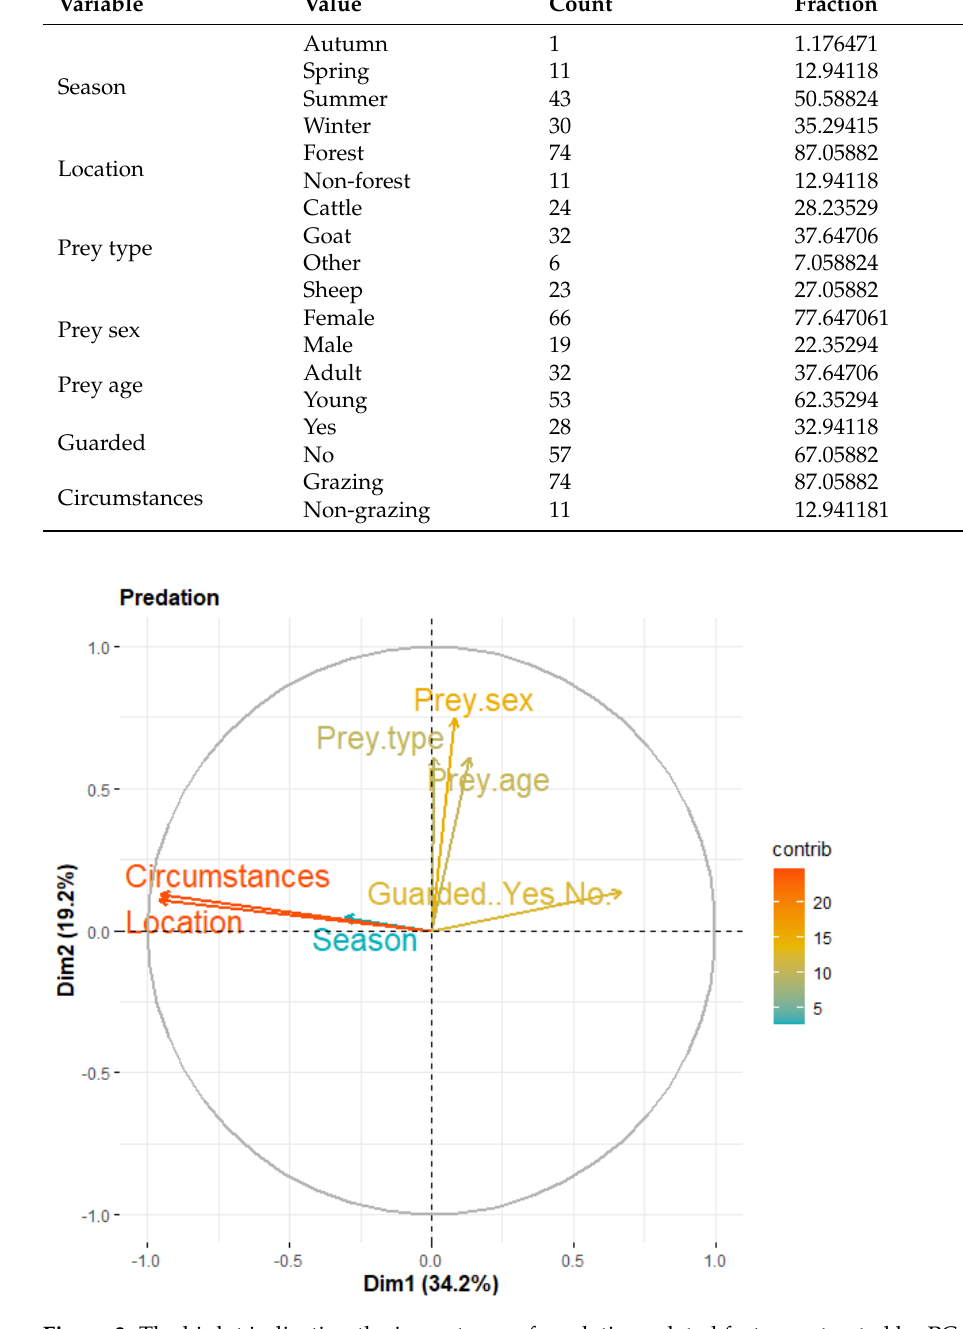
Figure 3. The biplot indicating the importance of predation-related factors extracted by PCA. The importance of each factor on predation is presented by orange color intensity .